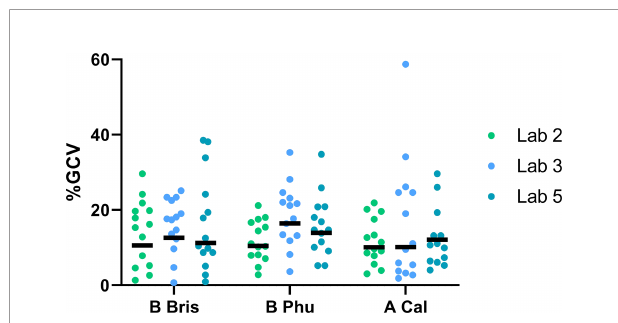
FIGURE 4 | Intra-laboratory performance using three in fl uenza strains is consistent. Three mismatched in fl uenza viruses were tested using the FLUCOP ELLA-NI SOP. A serum panel of 16 human sera was tested in three laboratories. Each laboratory carried out three independent runs. %GCV per sample is shown by lab for: B Bris (H9 with B/Brisbane/60/2008 NA), B Phu (H9 with B/Phuket/3073/2013 NA) and A Cal (H7N1 or H9N1 with A/ California/07/2009 NA). The geometric mean of %GCV is shown as a black bar (negative samples 12 and Ig- were excluded from